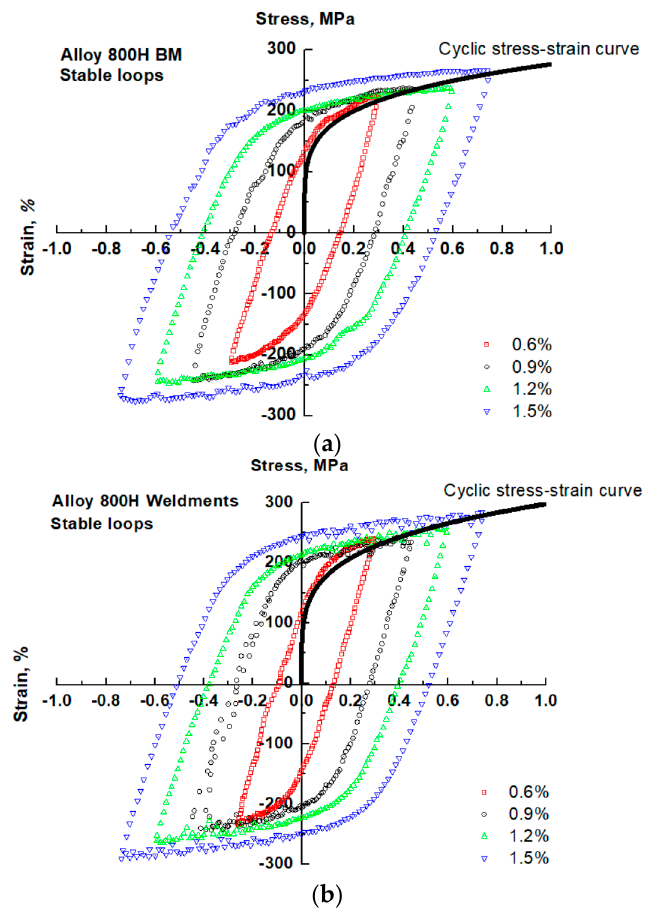
Figure 6. Comparison of mid ‐ life hysteresis loops for Alloy 800H: ( a ) BM and ( b ) weldments.